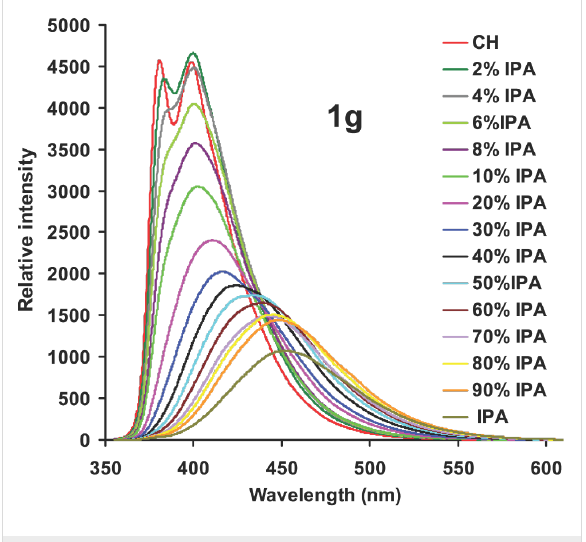
Figure 4: Effect of binary solvent system (cyclohexane-isopropyl alcohol) on the fluorescence emission of 1g (10 − 5 M). CH – cyclo- hexane, IPA – isopropyl alcohol, λ ex = 335 nm.